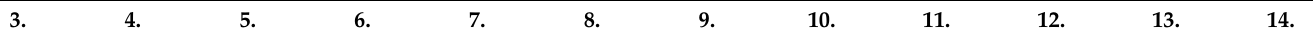
Table A5. Correlations between school-level constructs (correlation coe ffi cients and p values; N =